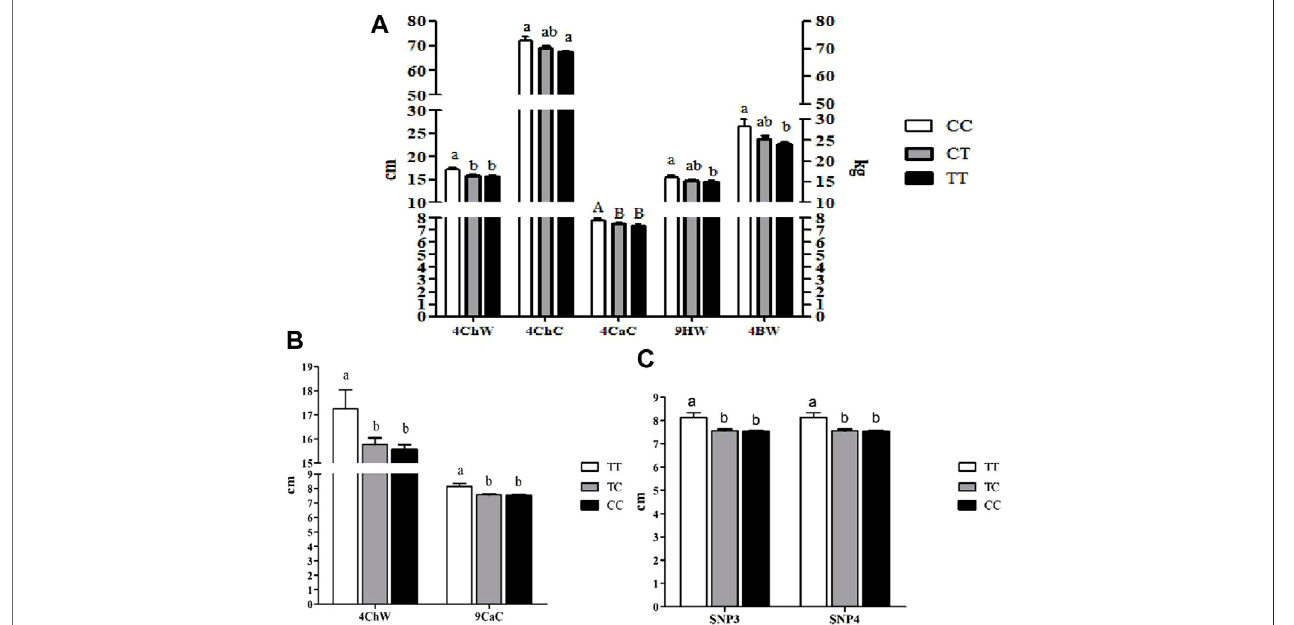
FIGURE3| AssociationanalysesofSNPsin SSTR5 withgrowthtraits ofHulunBuirsheep 1 . (A) AssociationanalysesofSNP1 in SSTR5 withgrowth traitsofHulun Buir sheep; 4ChW = chest width at 4 months of age; 4ChC = chest circumference at 4 months of age; 4CaC = cannon circumference at 4 months of age; 4HW = hip width at 4 months of age; 4BW = body weight at 4 months of age. (B) Association analyses of SNP7 in SSTR5 with growth traits of Hulun Buir sheep; 4ChW = chest widthat 4months ofage;9CaC=cannoncircumferenceat 9 monthsofage. (C) Associationanalyses ofSNP3 andSNP4 in SSTR5 withcannon circumferenceat 9 months of age of Hulun Buir sheep. a,b means with different superscript letters are signi fi cantly different ( p < 0.05). A,B means with different superscript letters are very signi fi cantly different ( p < 0.01). 1 A group size of Population genetics analyses was n = 233.